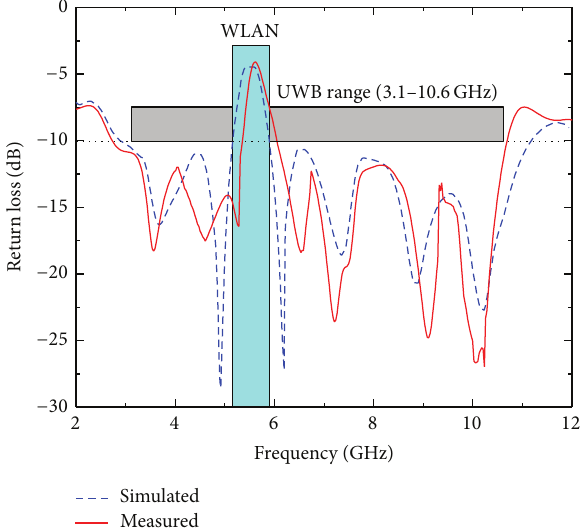
Figure 20: Simulated and measured results of return loss of the final MIMO